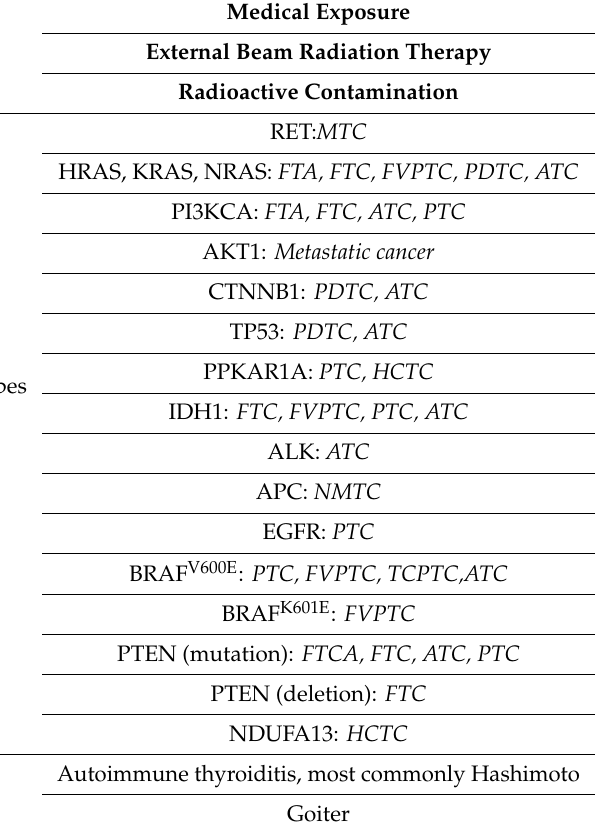
Table 1. Risk factors for thyroid nodules and factors indicative of higher malignancy